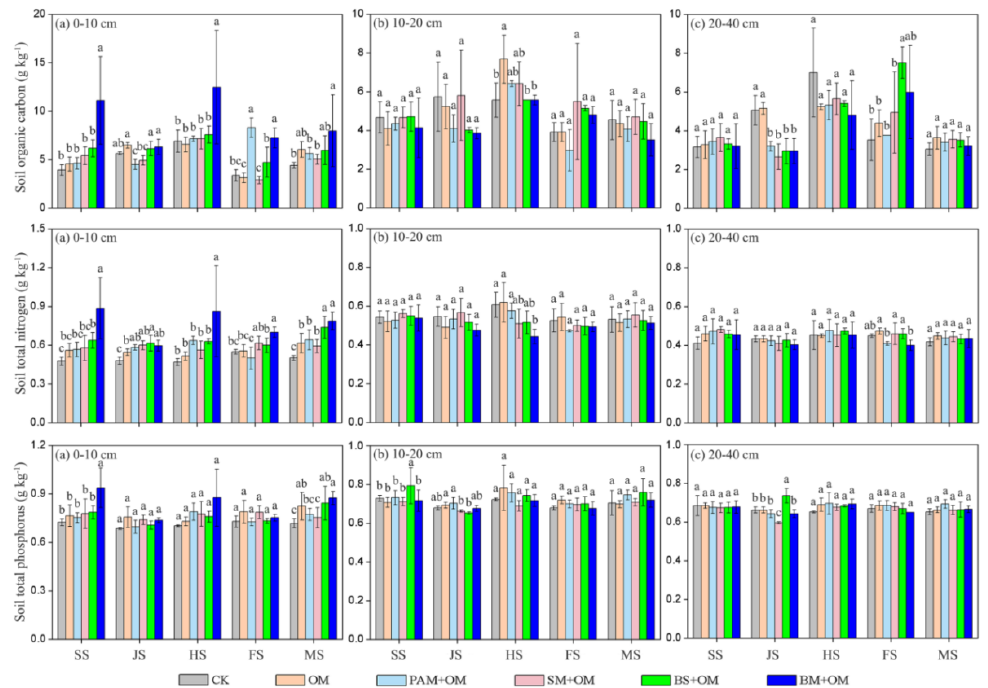
Figure 2. Dynamics of soil organic carbon, total nitrogen, and total phosphorus contents under different oat growth stages in 0–10 cm ( a ), 10–20 cm ( b ), and 20–40 cm ( c ). SS: seedling stage; JS: jointing stage; HS: heading stage; FS: filling stage; MS: maturation stage. Values are means of three replicates ± SD; error bars refer to standard deviation; values having different lowercase letters on the bars indicate significant differences among different treatments (least significant difference (LSD), p < 0.05).